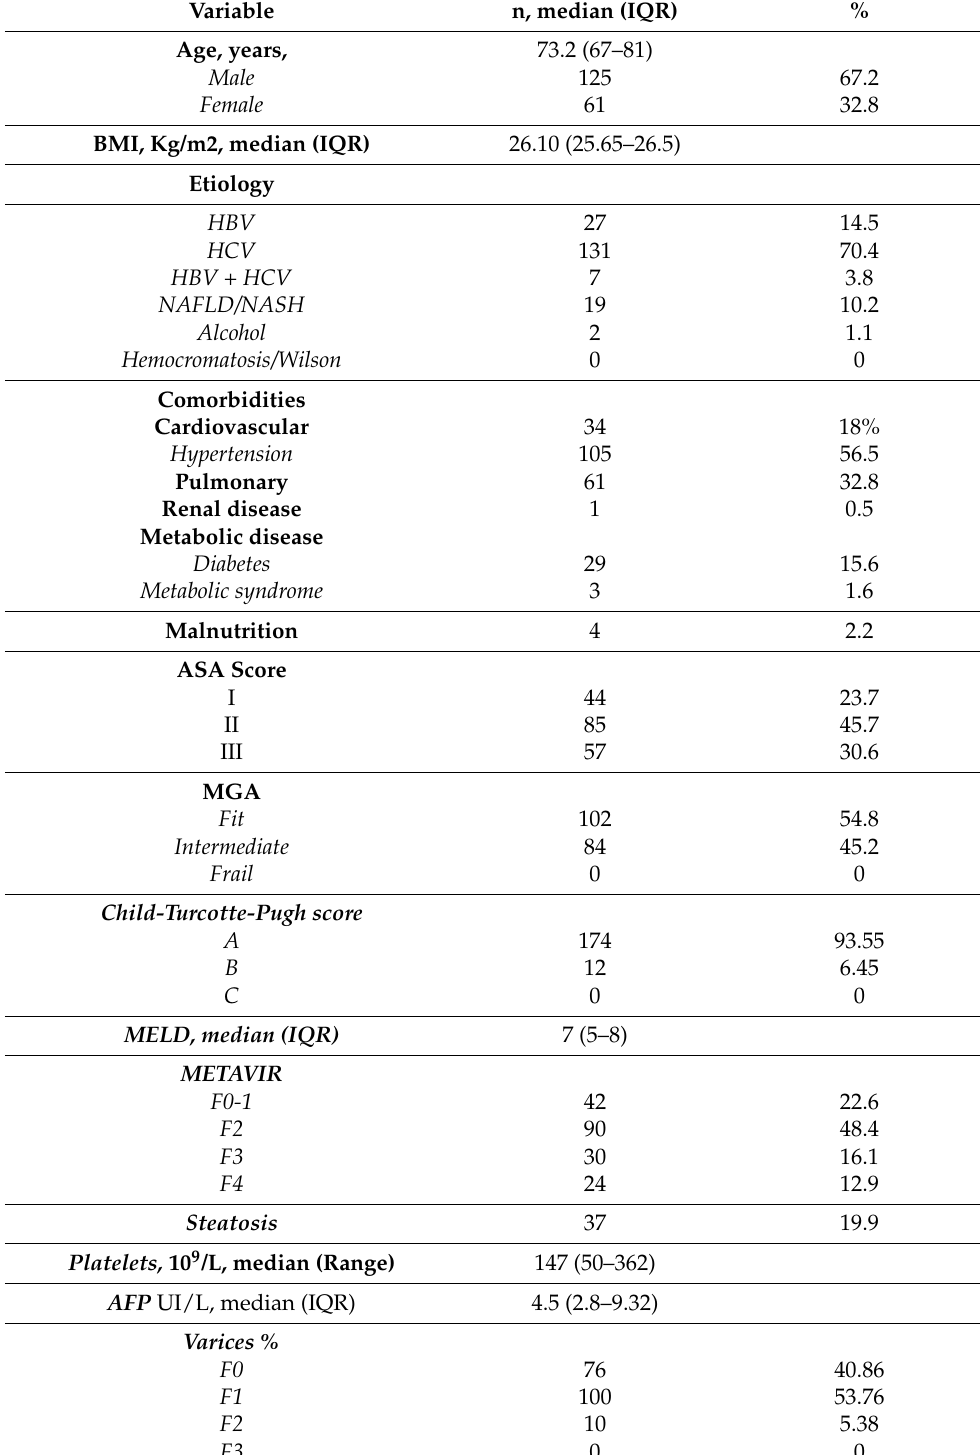
Table 1. Baseline characteristics of surgically treated HCC